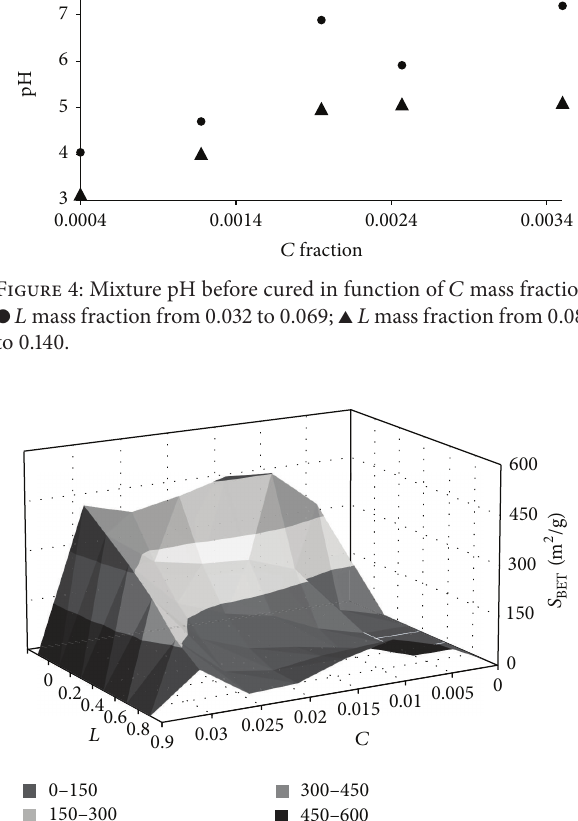
in function of pH. BET